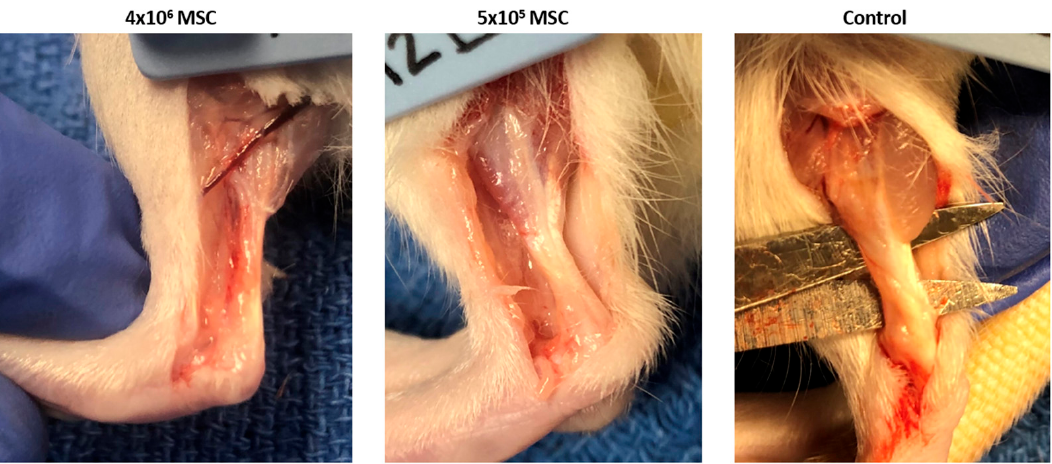
Figure 7. Gross appearance of the rat Achilles tendon 30 days after tendon injury and intralesional rAdMSC treatments at the indicated dosages. Tendons were assessed for size, presence of adhe- sions/scar tissue, relative vascularity, lesion visibility, and subjective assessment of repair.